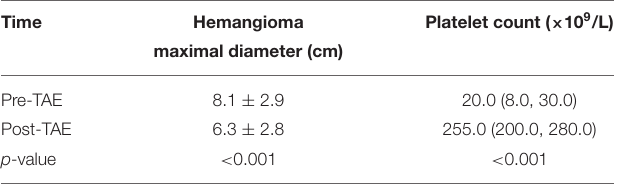
TABLE 2 | Hemangioma volume and platelet count before and after TAE (mean ± SD, n = 6). Time Hemangioma Platelet count ( × 10 9